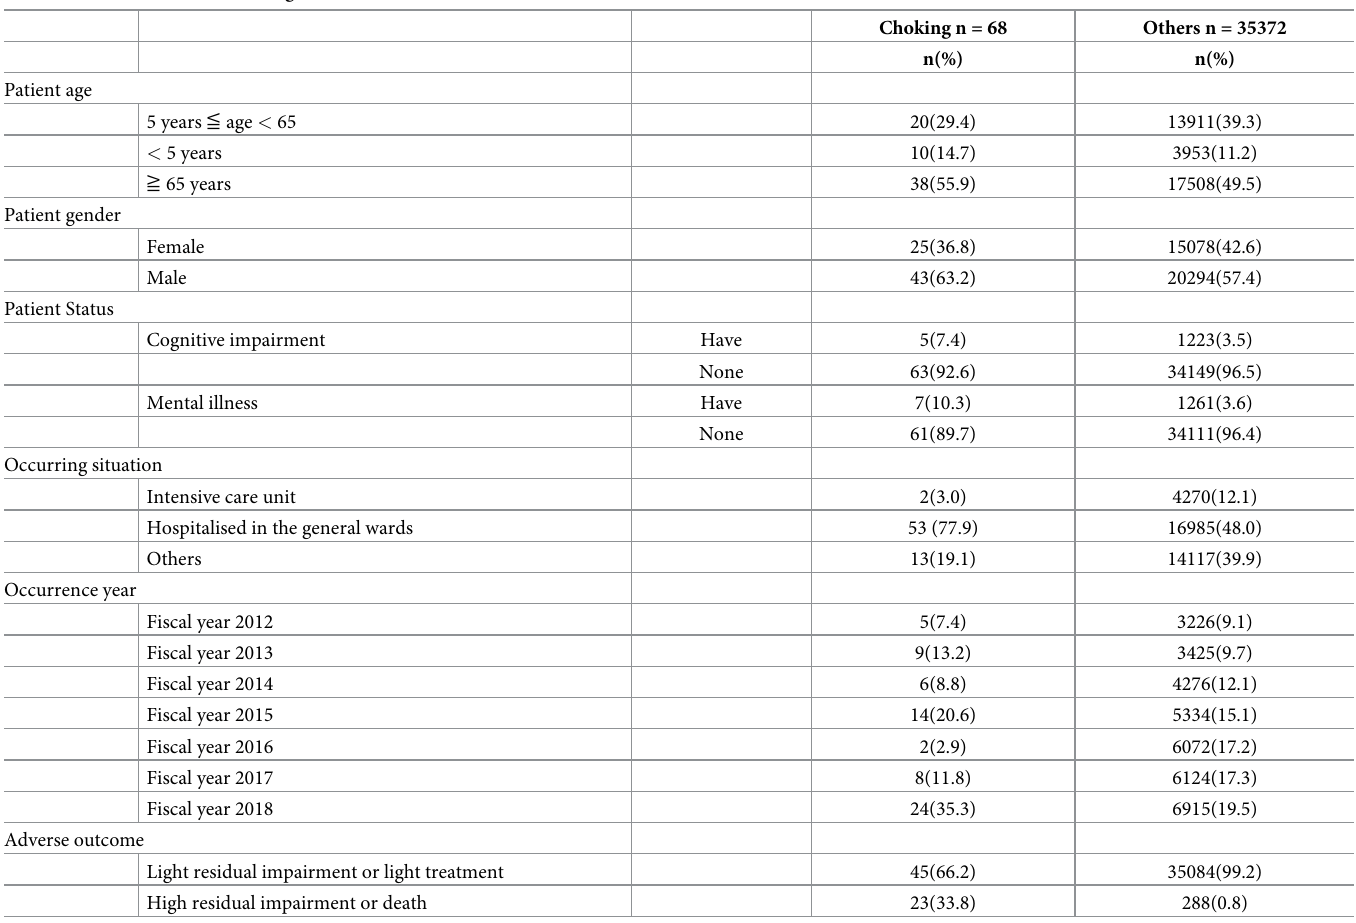
Table 1. Characteristics of choking